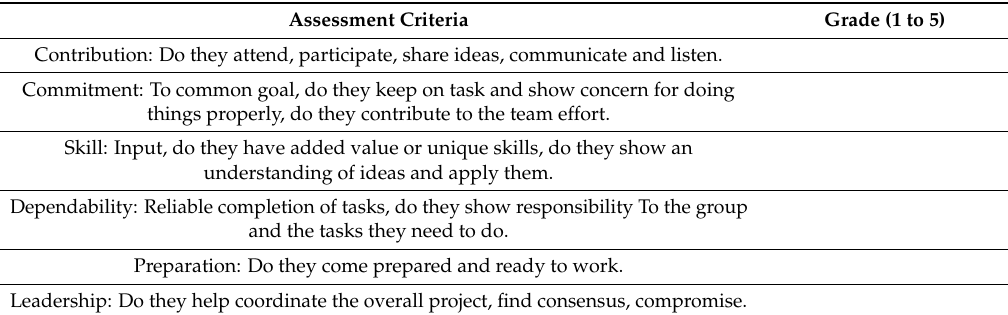
Table 11. Allotment of scores by all members (students) of the